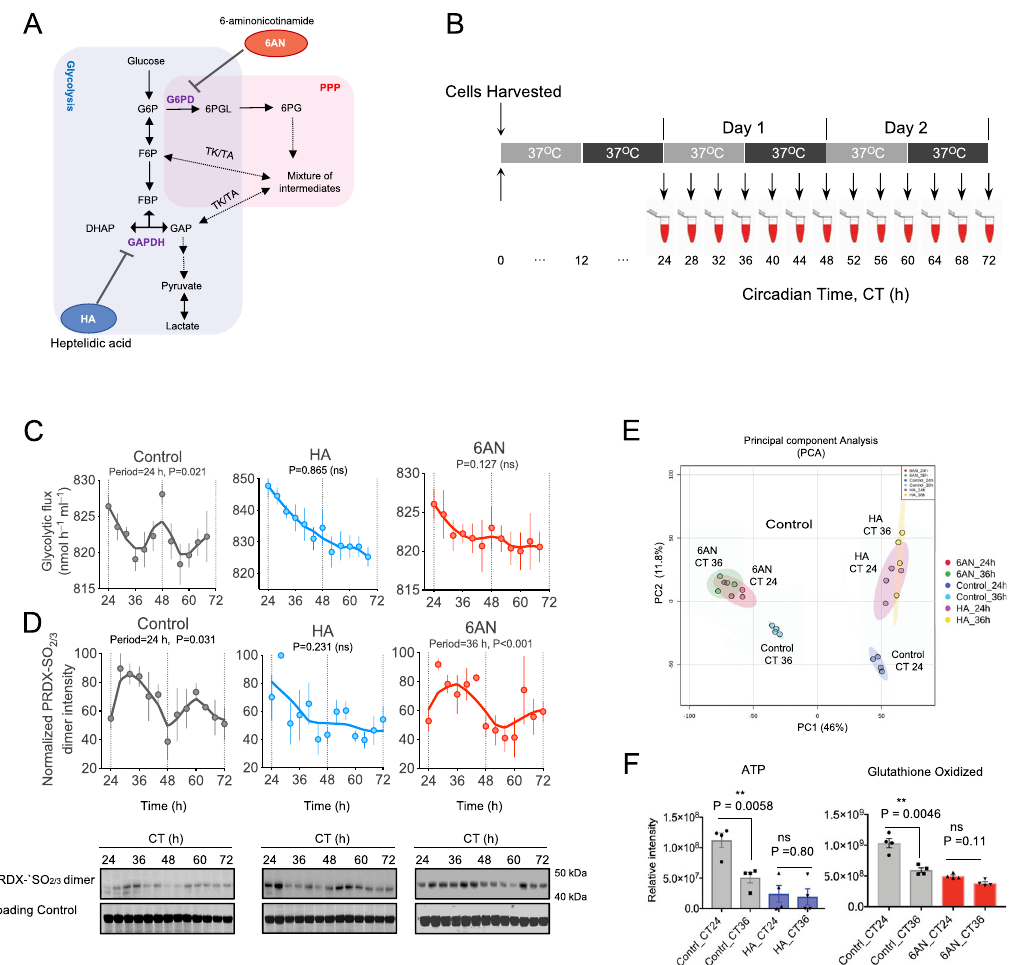
Fig. 5 Metabolic inhibition abolishes circadian metabolic fl ux and PRDX oxidation rhythms in human red blood cells (RBCs). A Schematic showing key steps and metabolites in glycolysis and the pentose phosphate pathway (PPP) and the points at which the glycolytic inhibitor, heptelidic acid (HA) and the PPP inhibitor, 6-aminonicotinamide (6AN), act in the pathways. G6P = Glucose-6-phosphate, F6P = Fructose-6-phosphate, FBP = Fructose-1,6- biphosphate, DHAP = Dihydroxyacetone phosphate, 6PGL = 6-Phosphogluconolactone, 6PG = 6-Phosphogluconate, GAP =